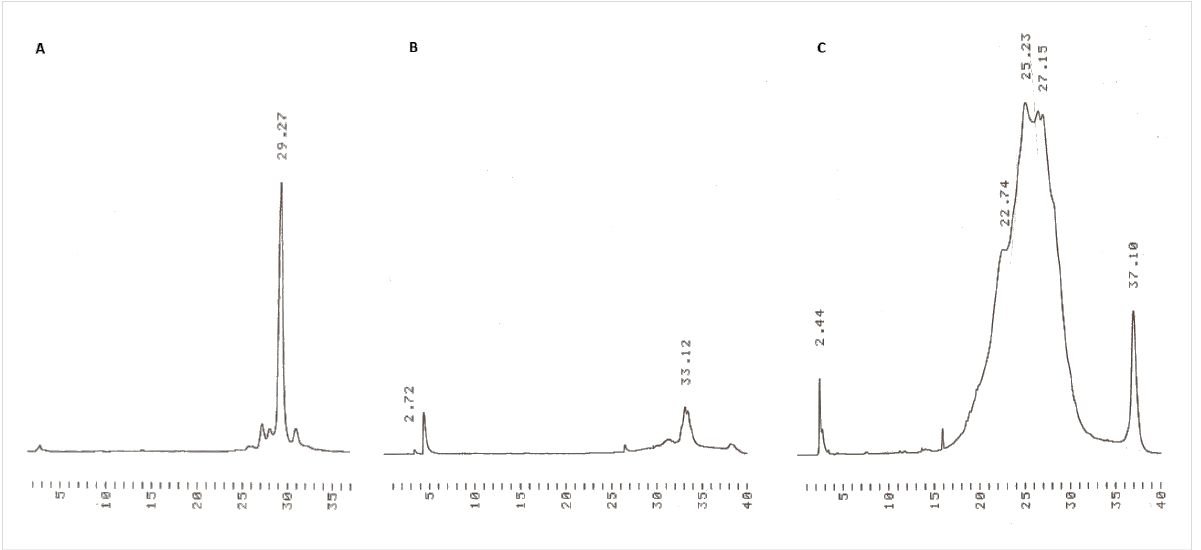
Figure 3: (A) HPLC traces for the precipitated support bearing phosphate-protected 3’-pTpdC Bz -5’-OH dimer 8b , and (B) HPLC traces of the filtrate after precipitation of 8b . (C) HPLC traces for the precipitated support bearing phosphate-protected 3’-pTpdC Bz pdG ibu -5’- O -DMTr ( 9 ). For the chromatographic conditions, see gradient A (for 8b and its filtrate) and gradient B (for 9 ) in the Experimental section.